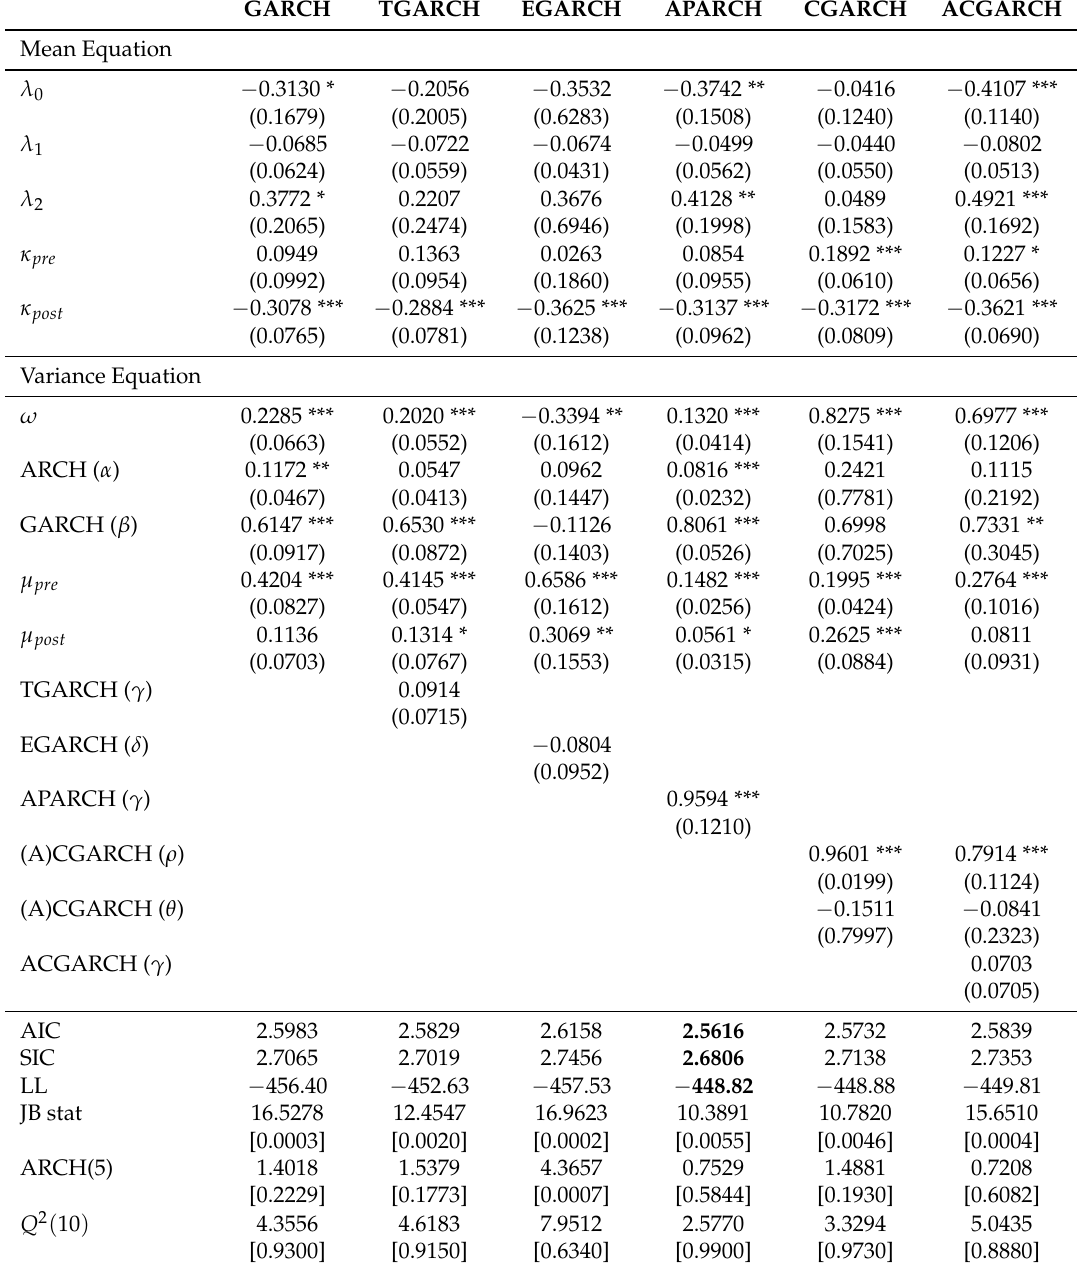
Table 4. GARCH-M Tests for Bitcoin for the sample of 360